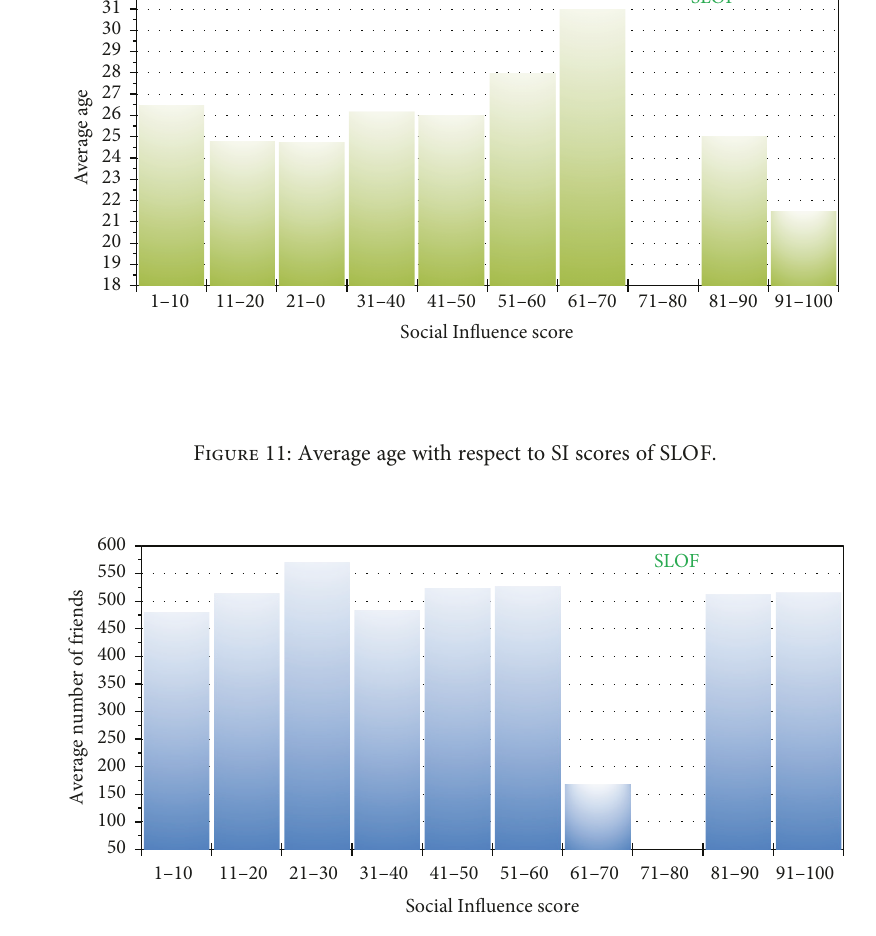
Figure 12: Average number of friends with respect to SI scores of SLOF